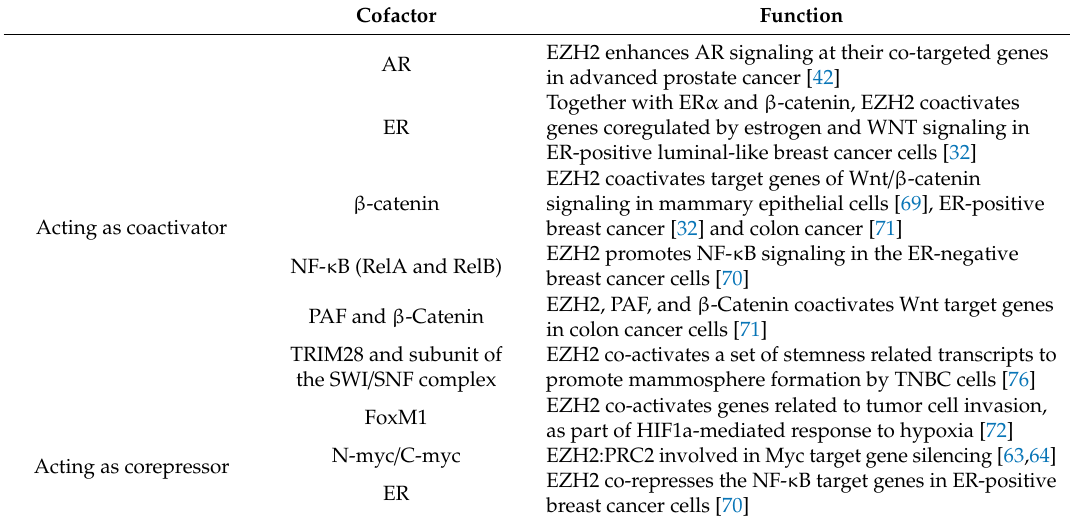
Table 2. Summary of EZH2 (cid:48) s noncanonical partners in